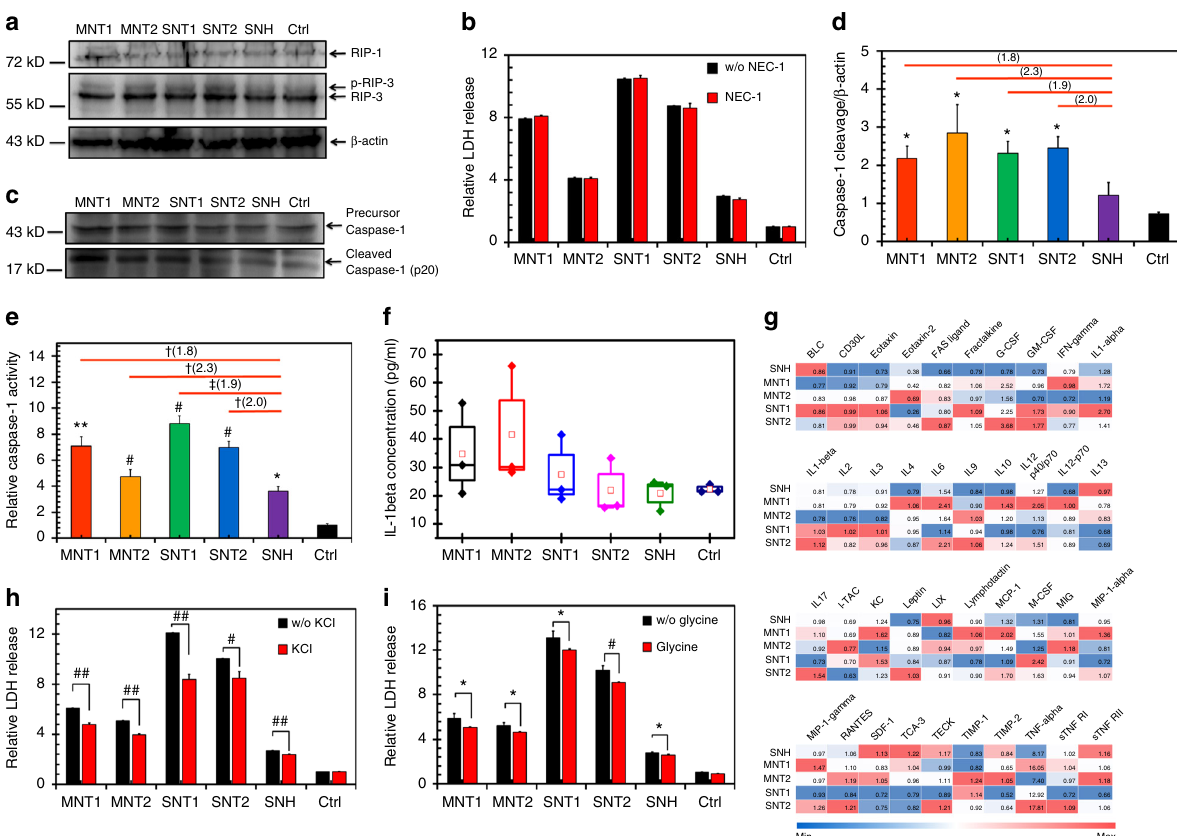
Fig. 5 SNH triggered less pyroptosis than CNT. a Western blot analyses of RIP1 and RIP3 kinases after nanocarbon incubations. b Cytotoxicity detection of different nanocarbons with and without RIP-speci fi c inhibitor NEC-1 addition ( n = 4). c Western blot analysis of caspase-1 cleavage induced by different nanocarbons. d Quantitative cleavage ratio measurement of caspase-1 in nanocarbon-incubated cells based on the integrated optic density (IOD) value detection during western blot imaging process ( n = 3). e Caspase-1 activity determination after cellular incubations of different nanocarbons based on speci fi c assay kit ( n = 3). f Extracellular IL-1 β measurement induced by different nanocarbons detected by ELISA. Each data point represented an independent detection, and the box denoted the standard deviation for each group ( n = 3). g The heat map of extracellular in fl ammatory cytokines induced by nanocarbons based on the protein array technology. The data in map represented the secretion changes of cytokines caused by nanocarbons compared to control group. h , i Cytotoxicity detections of different nanocarbons with and without two pan-inhibitors of pyroptosis, g KCl and h glycine additions ( n = 4). From b to h , data were all presented as means ± s.d. and the statistical signi fi cances were calculated by Student ’ s t -test. In d and e , data were compared with control (Ctrl) and SNH groups respectively. Versus Ctrl: * p < 0.05, ** p < 0.01, # p < 0.005, ## p < 0.001. Versus SNH: † p < 0.05, †† p < 0.01, ‡ p < 0.005. The values in brackets denoted the data ratios compared to SNH group. In g and h , data were compared with no inhibitor adding groups for each type of nanocarbons: * p < 0.05; # p < 0.005; ## p <